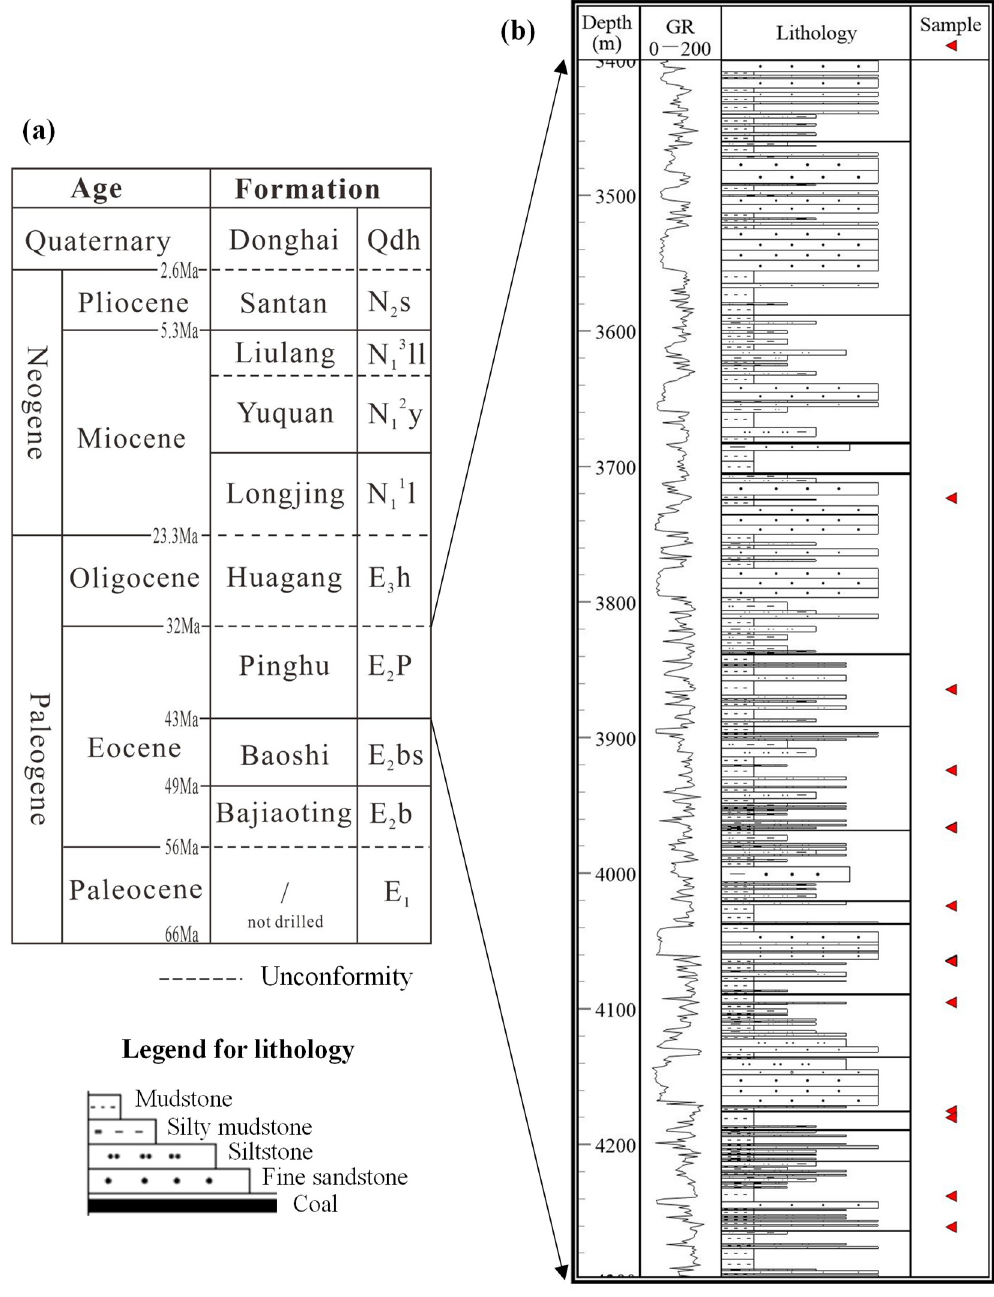
Figure 2. A generalized stratigraphy of the Xihu Sag ( a ) and stratigraphic column showing lithology of the middle–upper Eocene Pinghu Formation from well W-3 and sample locations ( b ).